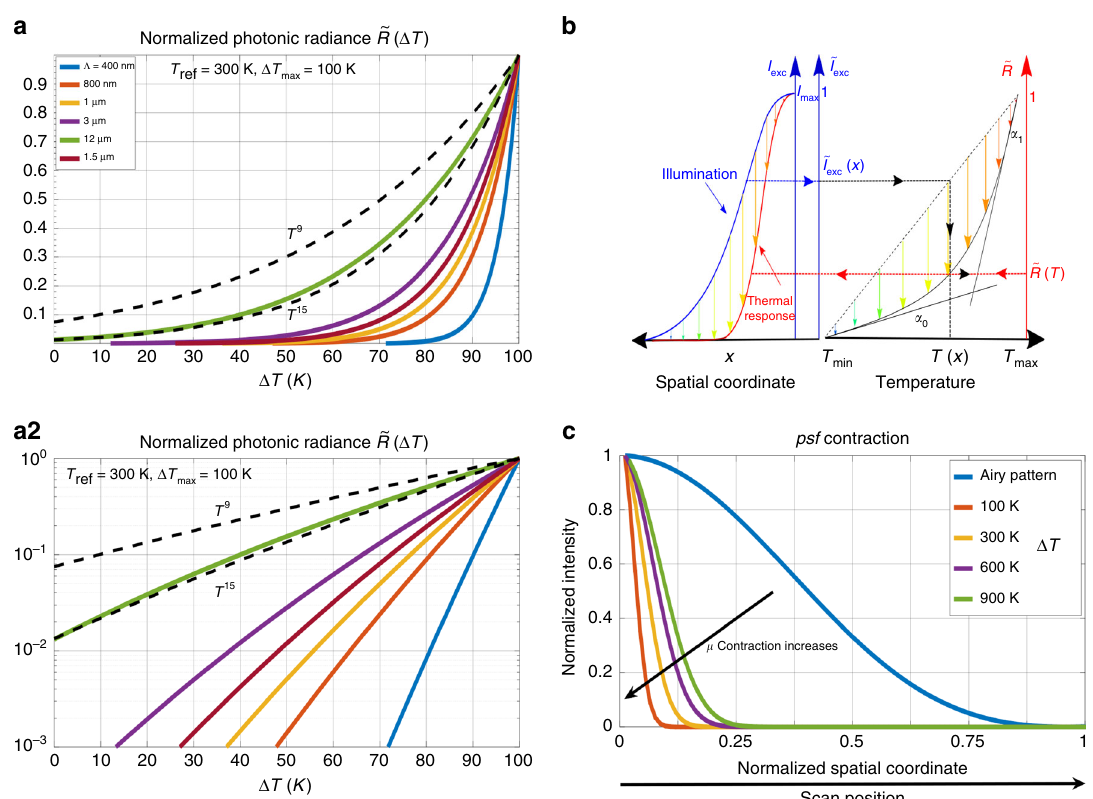
s − 1 m − 2 sr − 1 ) as a Fig. 2 Spatial compression of the excitation point spread function (psf). a Normalized blackbody photonic radiance (in units of # ph ¼ 100 K), for different values of the maximum integration wavelengths Λ . a1 is a linear plot, while function of the temperature rise Δ T (0 K (cid:6) Δ T (cid:6) Δ T max þ Δ T . b Spatial compression of an a2 is in semi-log scale. The photonic radiance is compared to two power laws ( T 9 and T 15 ) of the temperature T ¼ T ref illumination psf (left, blue) resulting from the nonlinearity of Plancks law (right). The contracted pro fi le of the effective thermal emission psf is represented on the left (red). The target temperature rises proportionally with the irradiance ~ I , and the thermal response ~ R as a function of the temperature follows exc — from left to right: 100, 300, 600, Plancks Law. c Example of the effect of thermal contraction on an Airy illumination psf (blue) for different values of T max and 900 K — for a spectrum integrated up to Λ ¼ 1.5 μ